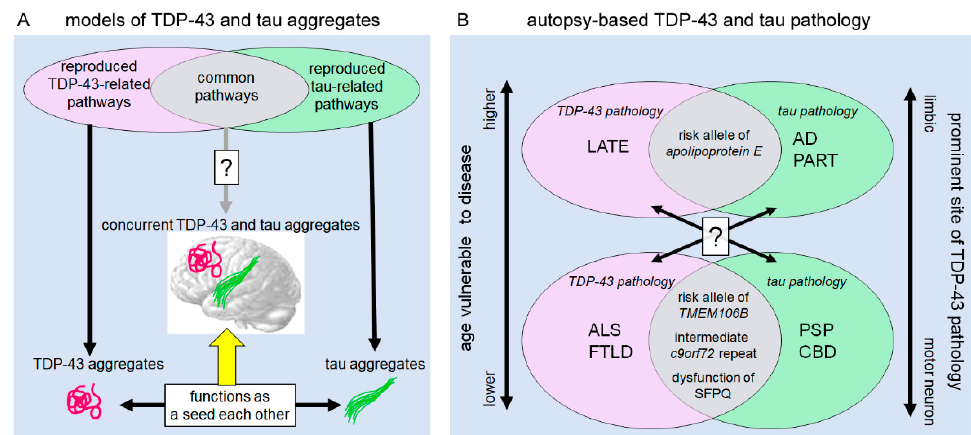
Figure 5. Overlapping of TDP-43 and tau pathologies in disease models and patients. ( A ) Although the upstream pathways driving TDP-43 or tau aggregates are hypothesized to overlap partially, the multiple proteinopathy comprising TDP-43 and tau pathology is unlikely to be reproduced by a single pathway in models. However, studies have shown that TDP-43 and tau aggregates have seed activities for each other, resulting in concurrent aggregations (a yellow arrow). ( B ) Autopsy-based research has suggested that the pathological findings of tauopathies and TDP-43 proteinopathies are partially overlapped and correlated with each other. Some studies have emphasized the possible links between AD and LATE or between PSP/CBD and ALS/FTLD-TDP, addressing shared patho- genic factors.